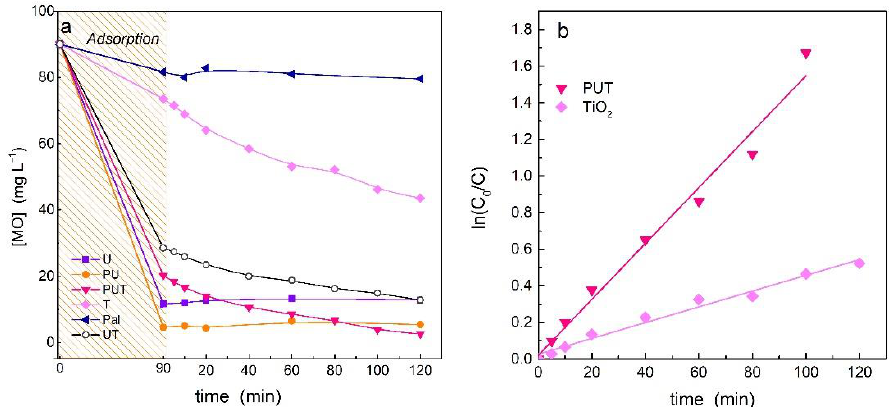
Figure 6. Photocatalytic removal of MO following the adsorption process ( a ) and the corresponding first-order kinetic plots ( b ). Experimental conditions: 90 mg · L − 1 initial MO concentration, 0.4 g · L − 1 of the material, pH = 5, volume = 50 mL, T = 25 °C, and adsorption period = 1.5 h.